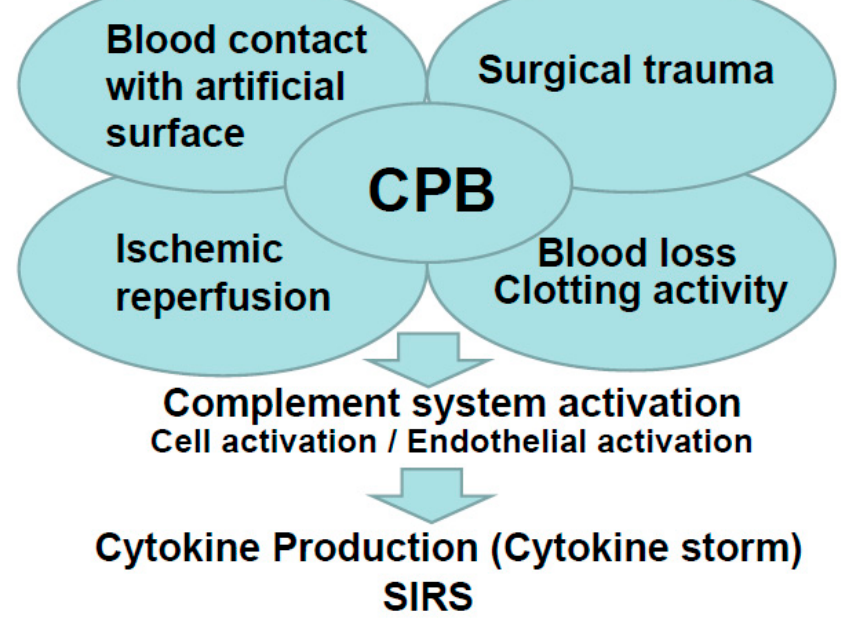
Figure 1. Summary of the inflammatory response in cardiopulmonary bypass (CPB).